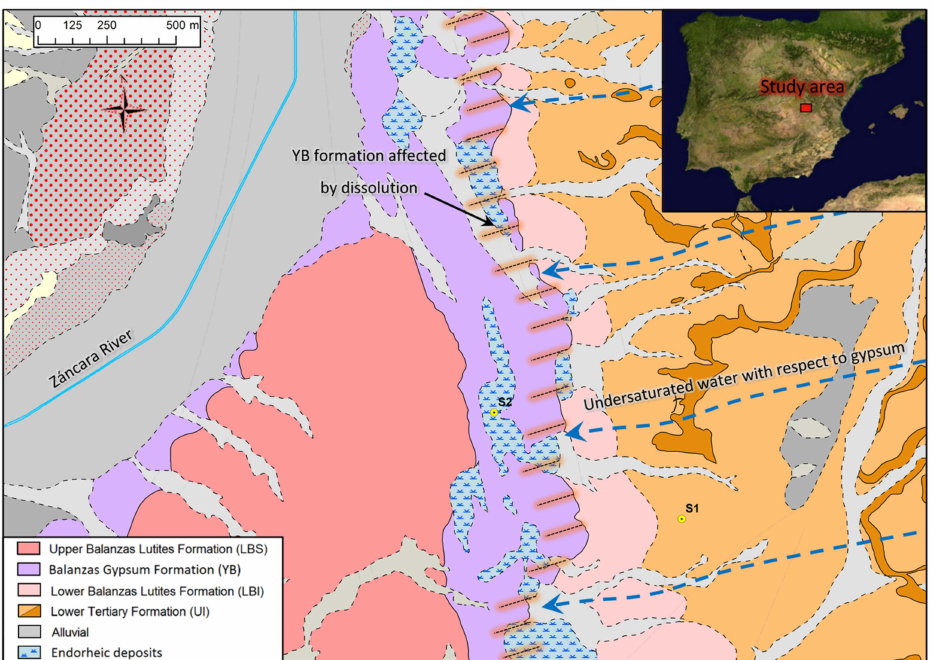
Figure 1. Geological map of the Villar de Cañas area showing the location of boreholes S1 and S2 and the Balanzas Gypsum formation (YB), which are affected by gypsum dissolution due to the inflow of groundwater that is undersaturated with respect to the gypsum from the lowermost LBI (Lower Balanzas Lutites) and UI (Lower Tertiary)